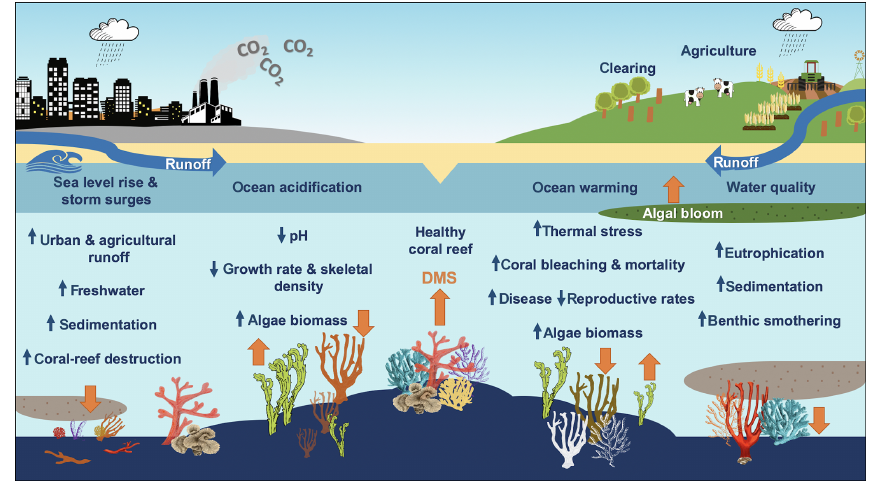
Figure 5. The impacts of climate change and land use on coral reefs. Orange arrows reflect the predicted increase or decrease in DMS emissions from the coral holobiont and marine micro- and